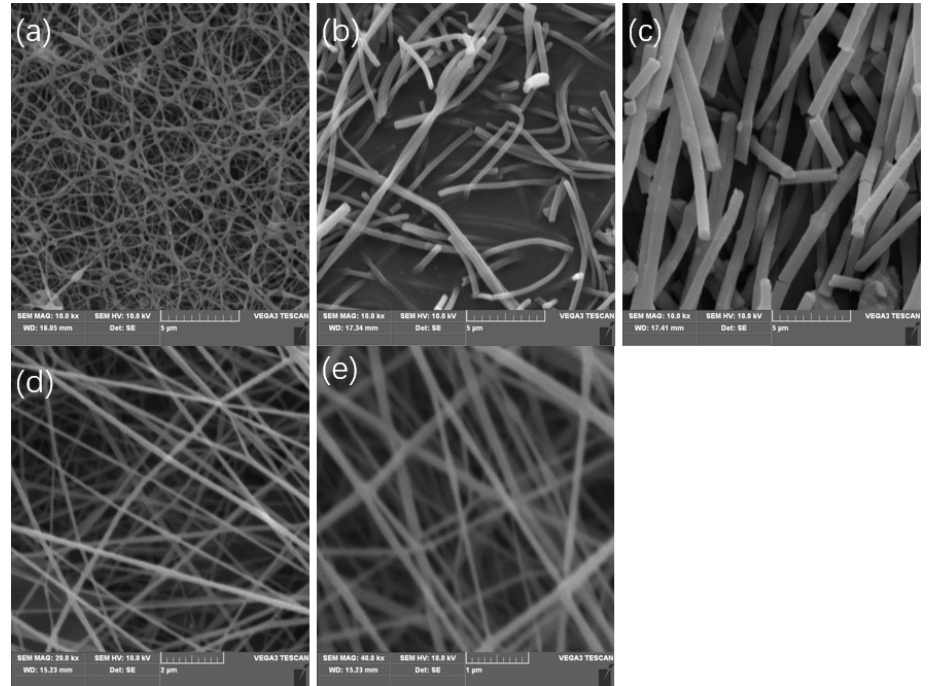
Figure 4. The SEM images of the fibers produced with the solvent of ( a ) pure DMF, ( b ) 5 mL of DMF + 2 mL of acetone, ( c ) 5 mL of DMF + 1 mL of acetone, ( d ) 5 mL of DMF + 1 mL of chloroform + 1 mL of acetone, and ( e ) 5 mL of DMF + 1 mL of chloroform. ( a – c ) 10 kx, ( d , e ) 20 kx.